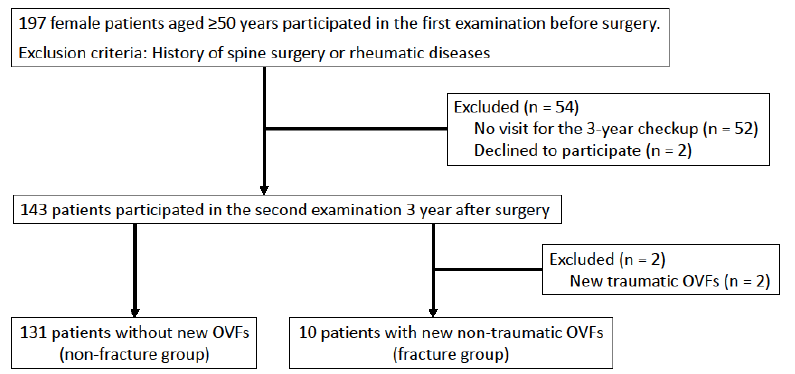
Figure 1. Study flowchart. The baseline study included 197 female patients aged ≥ 50 years who were scheduled to undergo surgery for lower-extremity degenerative diseases, of whom 54 were excluded from the study because they failed to attend the three-year postoperative checkup. Two patients were excluded because of traumatic OVF occurrence.